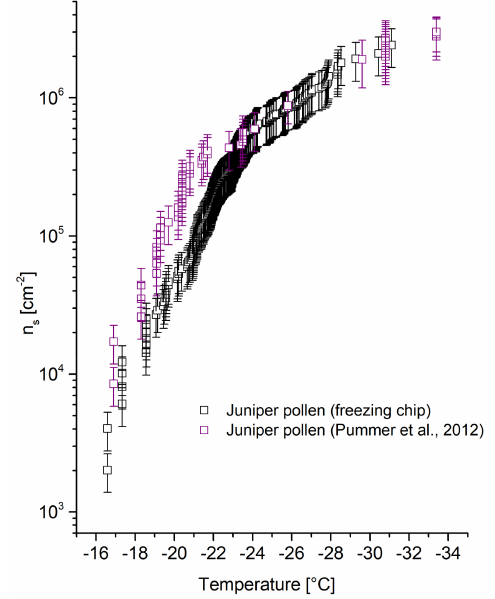
Figure 7. The n s values of juniper pollen determined with the freezing chip and compared to already published data [26]. The error bars of the n s values originate from the estimation of the corresponding droplet diameter of 40 µ m ± 10% and weighing